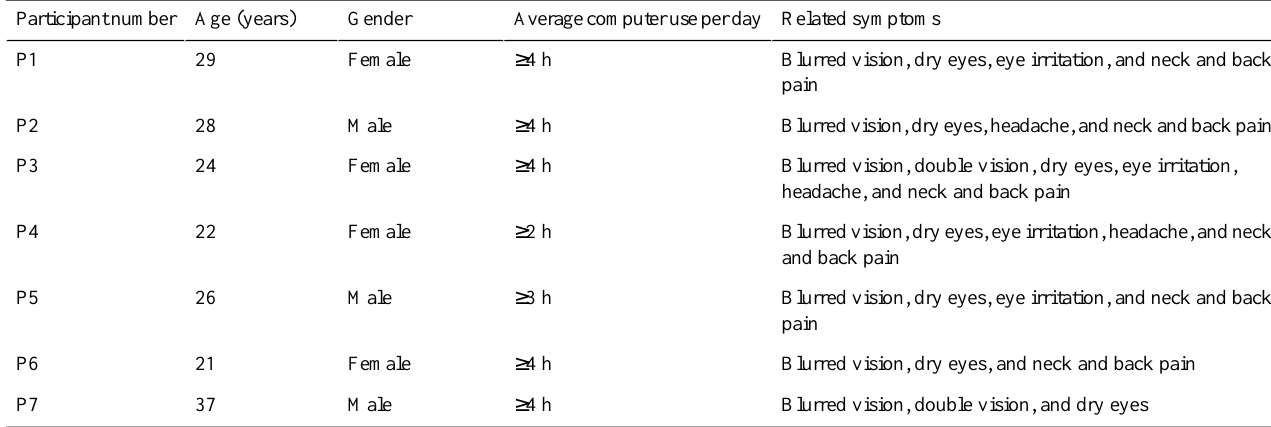
Table 1. Information of the participants in the focus group study.